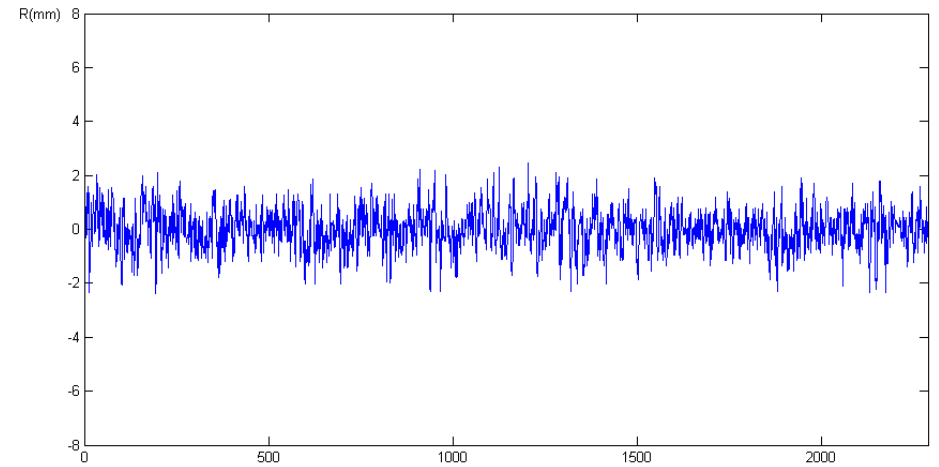
Figure 2. Zero-baseline double difference residuals for a pair of multi-constellation Leica GS10 in July